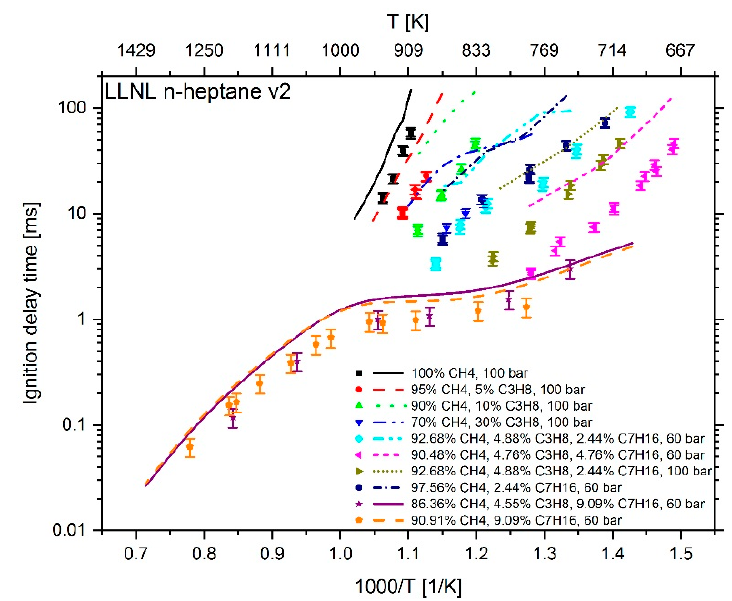
Figure 5. Experimental data (symbols) [6,7] versus model prediction (lines) using the Lawrence Livermore National Laboratory (LLNL) n -heptane v2 mechanism [22].